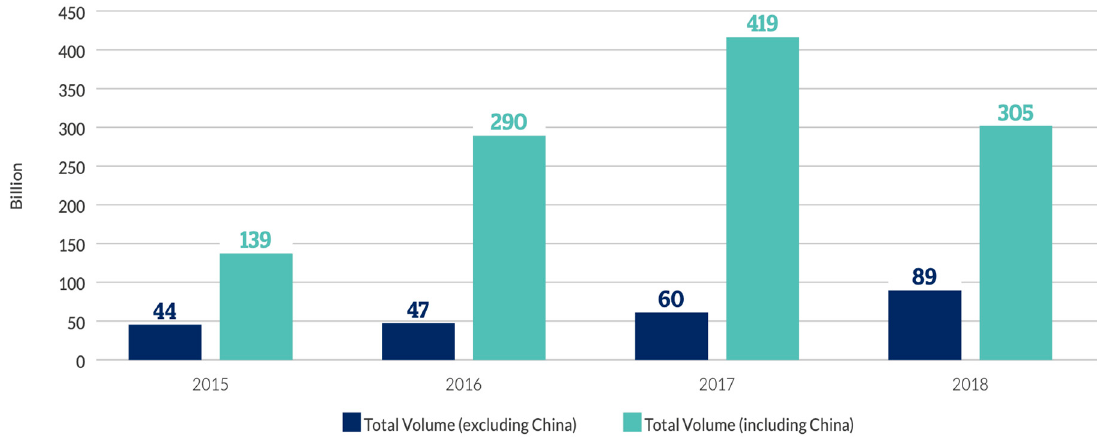
Figure 1. Size and growth of alternative finance market (billion USDs). Source: Cambridge Center for Alternative Finance Report 2020.